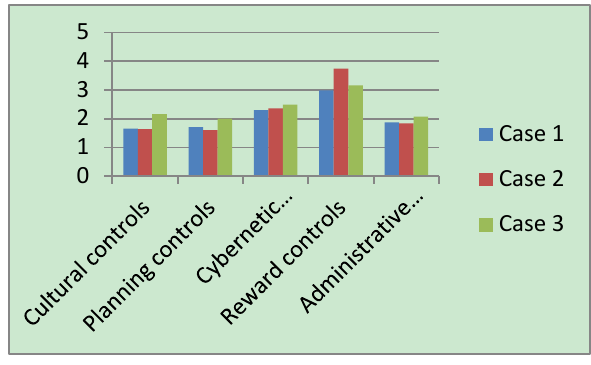
Figure 2. Amount of challenge for reflection—individual level.